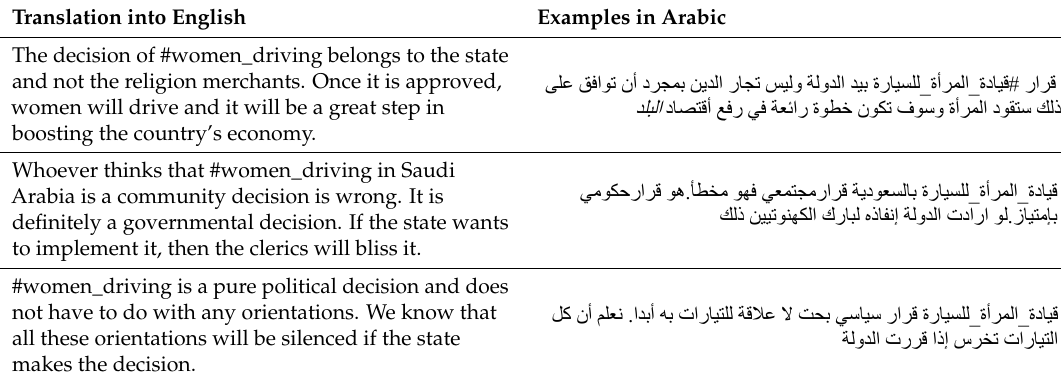
Table 4. Examples of normalizing women driving by affirming the state’s authority. Translation into English